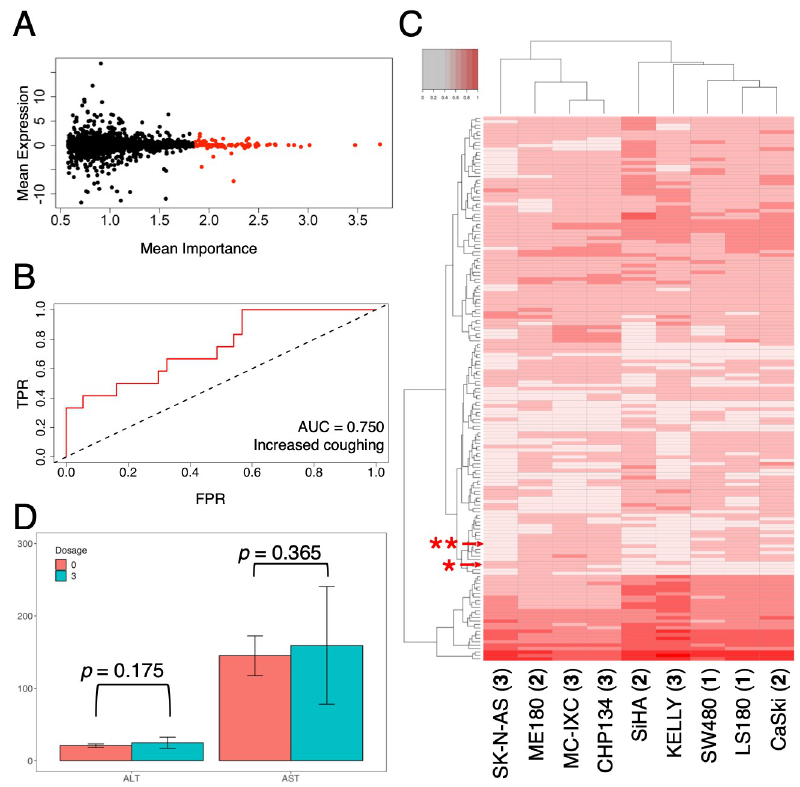
Fig 3. Side effect evaluation of PI polyamides. (A) comparison of gene expressions and its relative importance in the prediction model; vertical axis, Z-normalized mean expressions for a particular gene in training data sets; horizontal axis, importance in terms of mean Gini index; top 100 most important genes were highlighted in red. (B) sample receiver operating characteristic curve for the side effect of increased coughing; FPR , false positive rate; TPR , true positive rate; AUC , area under curve (0.750). (C) Hierarchical clustering of common potential side effects of polyamides 1–3 from expression profiling; Cell lines and the corresponding polyamide are indicated in parentheses; side effects with likelihood scores are indicated in increasing shades of red. Arrows and asterisks indicate AST ( � ) and ALT ( �� ) increases. (D) AST and ALT levels of ME180 xenograft in Balb/c nude mice after 30–35 d of exposure to 3 mg/kg polyamide 2 (cyan) or DMSO (0 mg/kg; orange). Statistical significance is assessed by two-sample t -test; error bars indicate mean ± SD.